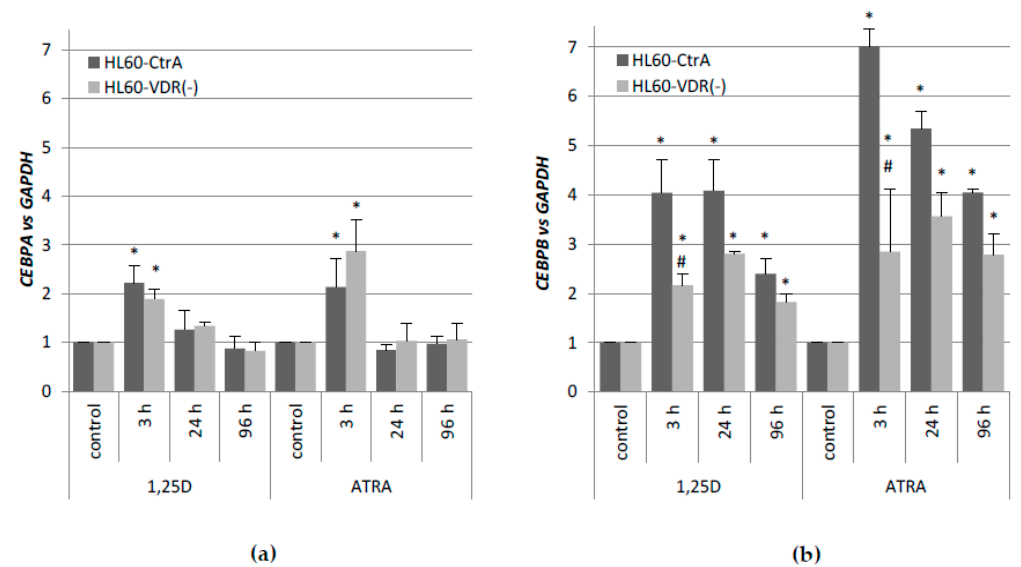
Figure 5. Expression of CEBPA ( a ) and CEBPB ( b ) genes in HL60-CtrA and HL60-VDR( − ). Cells were exposed to 10 nM 1,25D or 1 µ M ATRA and after desired time the expression of CEBP genes was measured by Real-time PCR. The bars represent mean values of the fold changes ( ± SEM) in mRNA levels relative to GAPDH mRNA levels. Expressions in control cells were treated as calibrators. Values that are significantly different from those obtained from respective controls cells are marked with an asterisk (* p < 0.05); values that differ significantly from those obtained from respective HL60-CtrA cells are marked with hash (# p < 0.05).